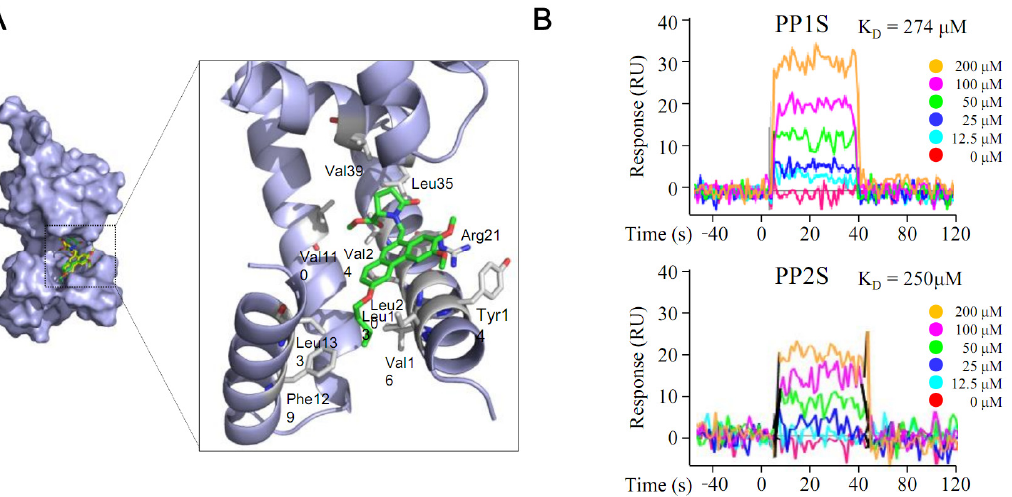
Figure 5. Interaction between PPs and Rv2887 protein. The interaction between PPs and Rv2887 protein was confirmed by ( A ) in silico and ( B ) SPR experiments. As the PPs increased to 200 μ M, the response value increased concentration-dependently. Here, PP1S and PP2S have molecular weights of 423 and 465, respectively, and 200 μ M represents 84.6 and 93.0 μ g/mL, respectively.